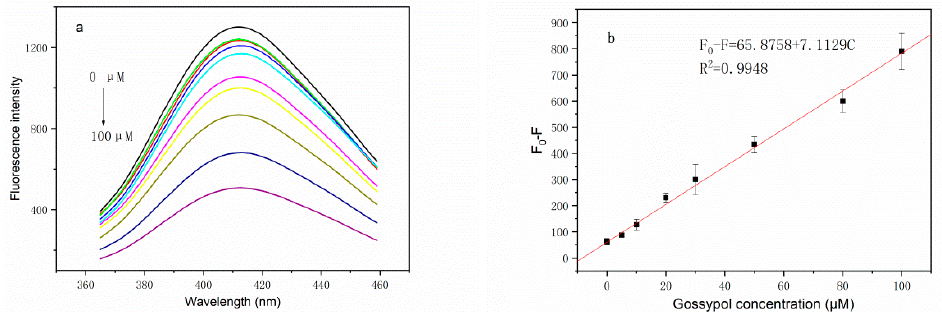
Figure 3. ( a ) Fluorescence spectra of the BSA-Cu NCs in the presence of different gossypol concentrations. Conditions: BSA-Cu NCs, 21 mg L − 1 ; Tris-HCl solution, 0.1 mM; pH = 7.4. The concentrations of gossypol were 0.00, 0.01, 0.10, 5.00, 10.00, 20.00, 30.00, 50.00, 80.00, and 100.00 µM. ( b ) Linear relationship between the decrease in fluorescence intensity and the concentration of gossypol. Error bars were estimated from three replicate detections.